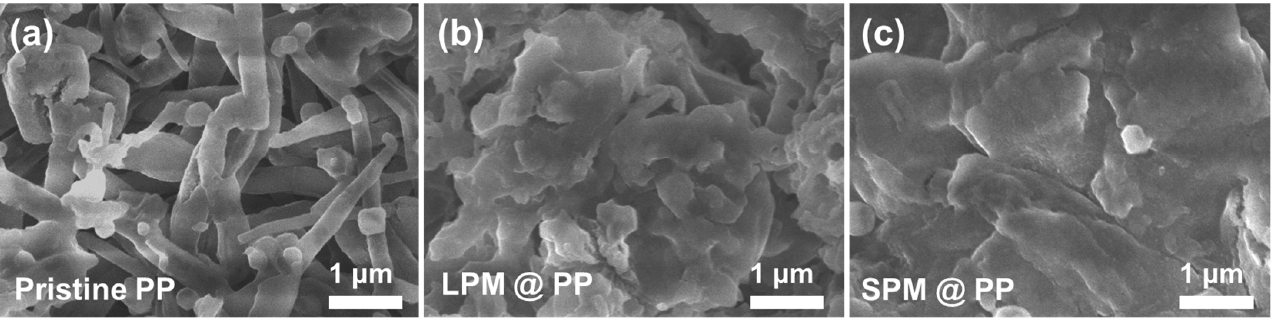
Figure 6. Post-mortem examinations after cycling. SEM images of the cell with ( a ) pristine PP sepa- rator, ( b ) LPM-coated separator, and ( c ) SPM-coated separator.